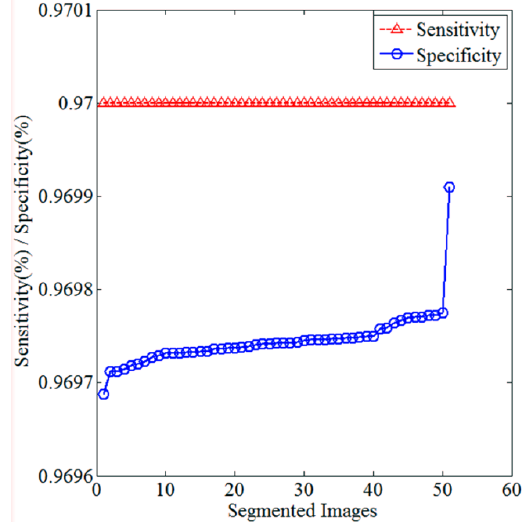
Fig. 5. Sensitivity and